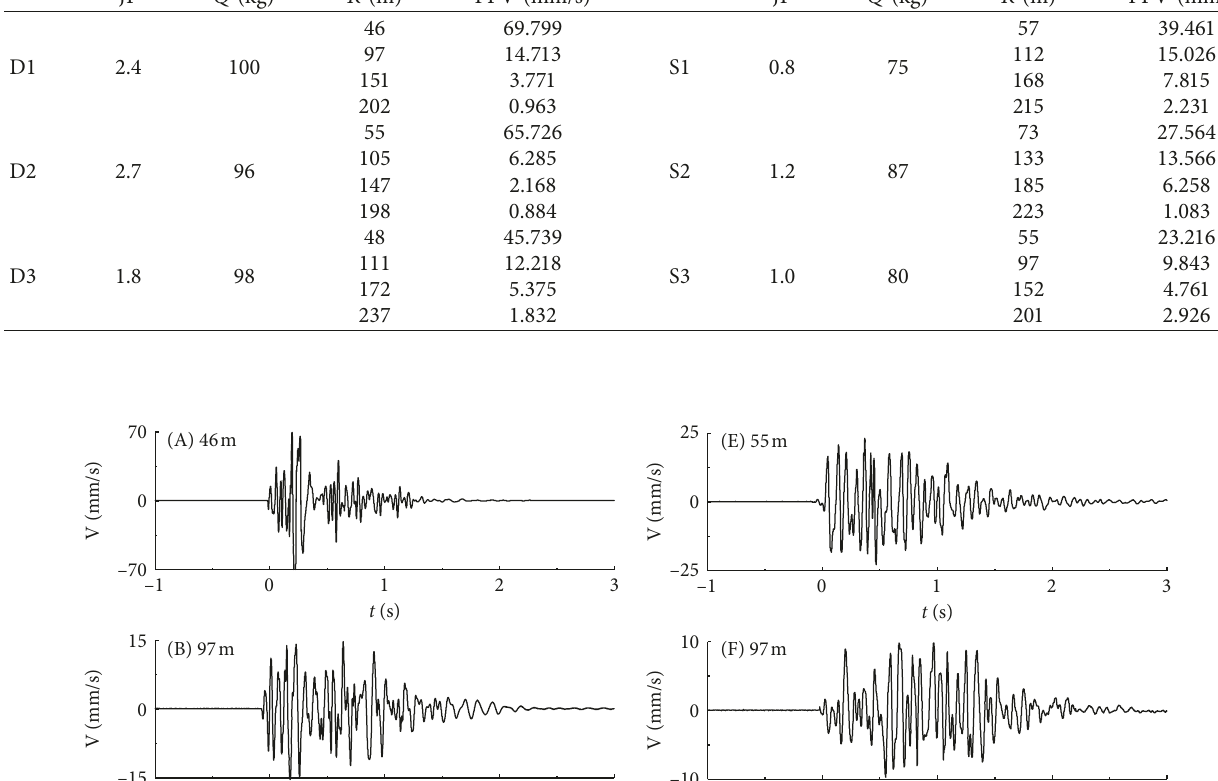
Table 3: Summary of the blasting-induced vibration data at Baideng phosphorite.